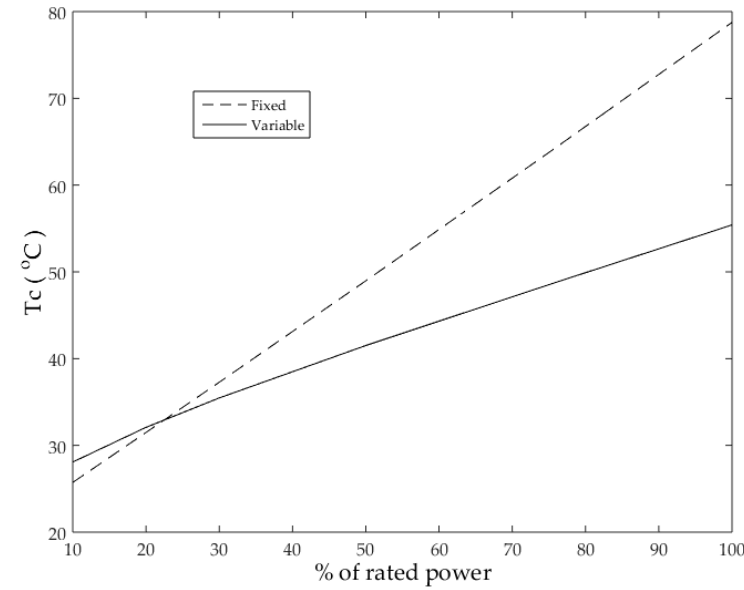
Figure 15. Calculated output case temperature variation with fixed and the proposed VSF PWM.